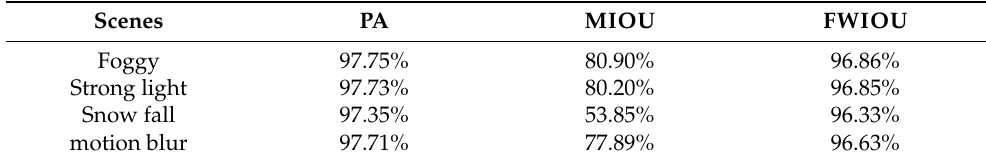
Table 4. The robustness test metrics in the four